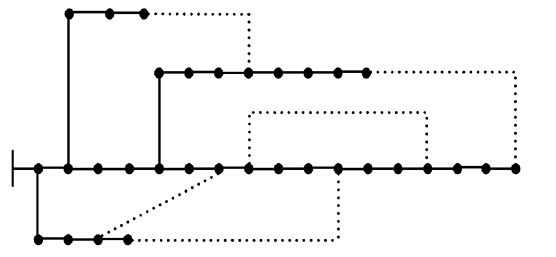
Fig. 5: One-Line Line Diagram of IEEE 33-Bus Test System Table 3: Loops of 33-Bus Test System